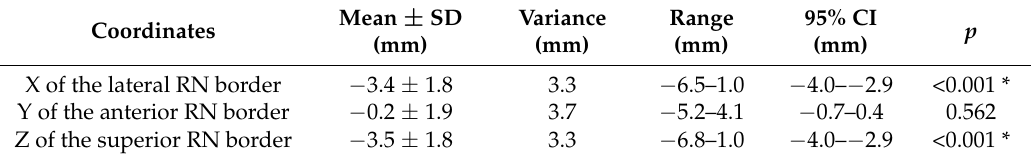
Table 3. The distances between the different RN borders and the final active electrode coordinates.